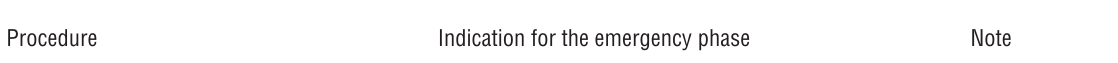
Table 1 - Factors potentially affecting the choice of the different urological procedures during COVID- 19 pandemic (8).